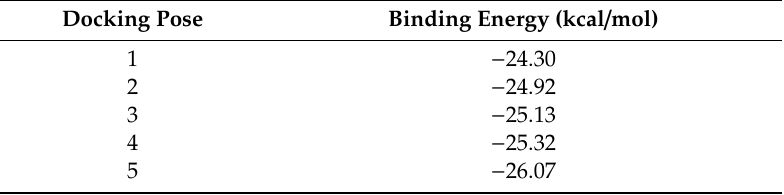
Table 6. Docking score obtained for the top five low-energy conformational